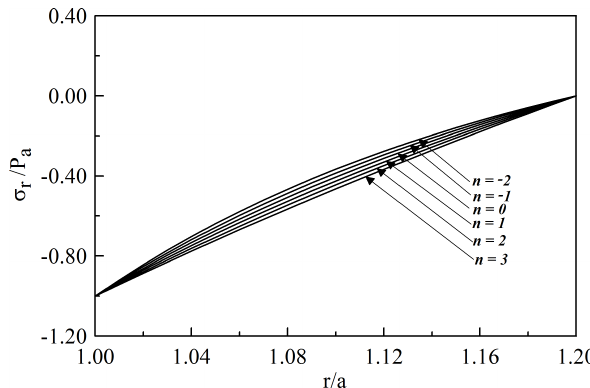
Figure 28: Radially distributed radial stress